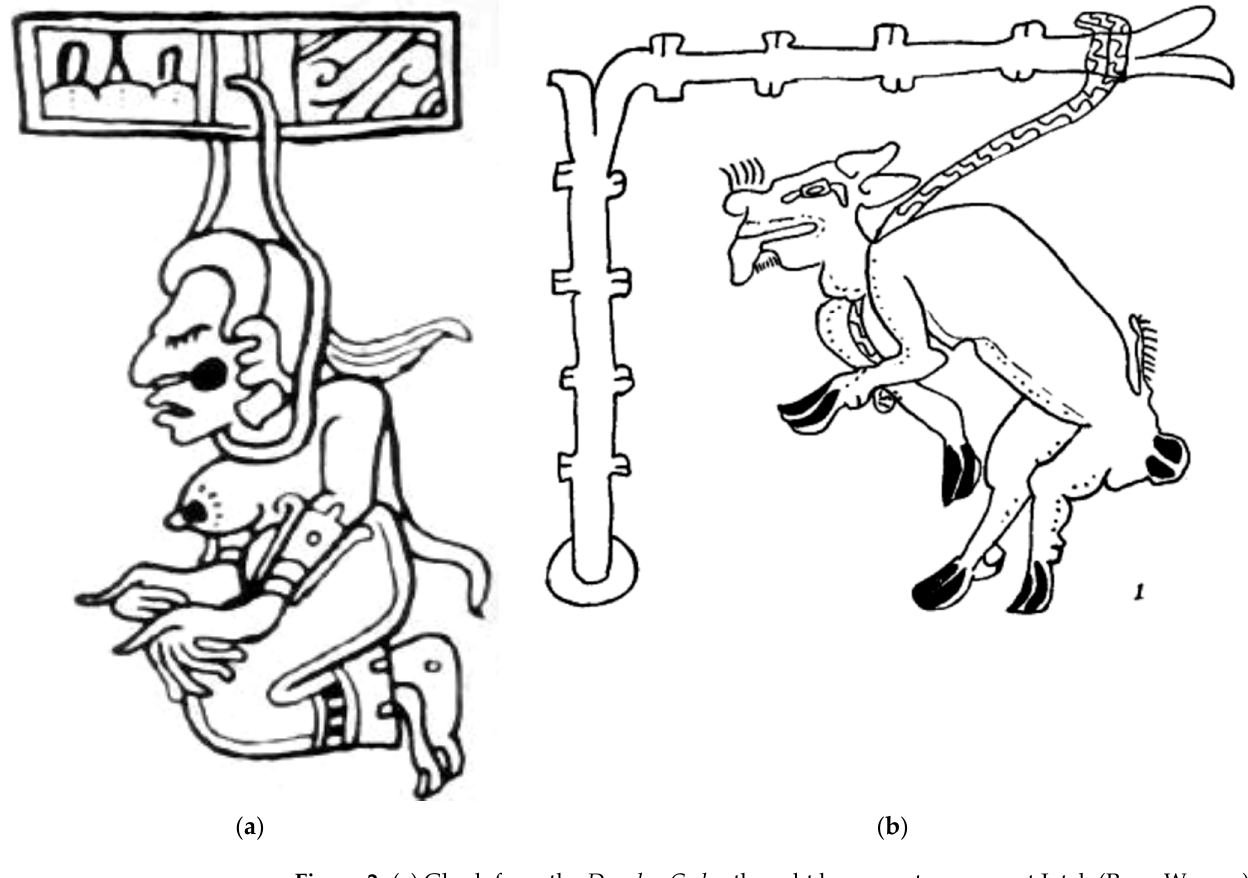
Figure 2. ( a ) Glyph from the Dresden Codex thought by many to represent Ixtab (Rope Woman) as a suicide goddess, reinterpreted here as Ixtab as a hunt goddess wearing a rope snare as a symbol of her method of entrapment. Redrawn by Melissa X. Stevens from an image by William Gates (de Landa and Gates [1937] 2011, p. 73) and used by permission; ( b ) Glyph, “Yucatan deer caught in a snare, Tro-Cortesianus 48b” (Tozzer and Allen 1910). In the Public Domain. (Tro-Cortesianus is now called the Madrid Codex.).